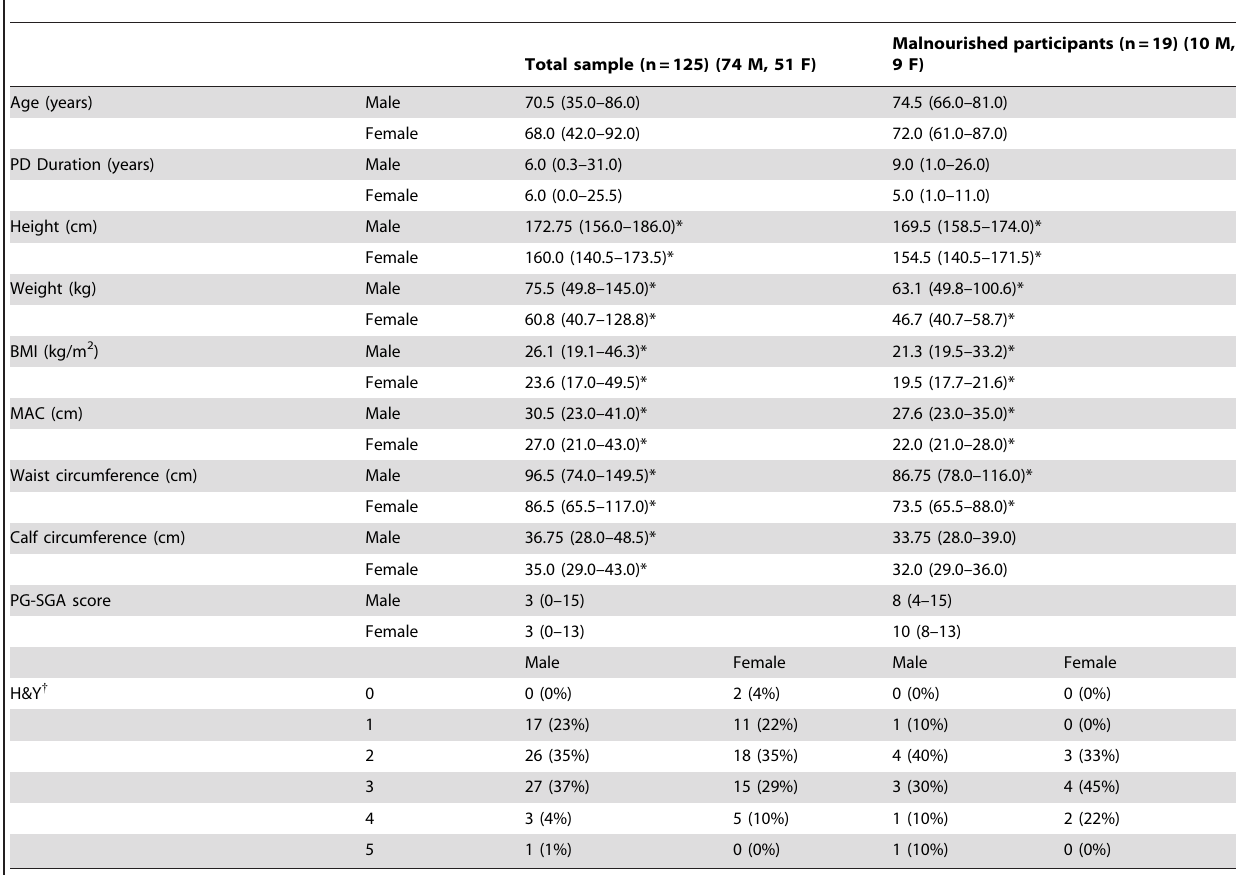
Table 3. Characteristics of the total sample and of the malnourished participants compared between genders using Mann- Whitney analysis and reported as median